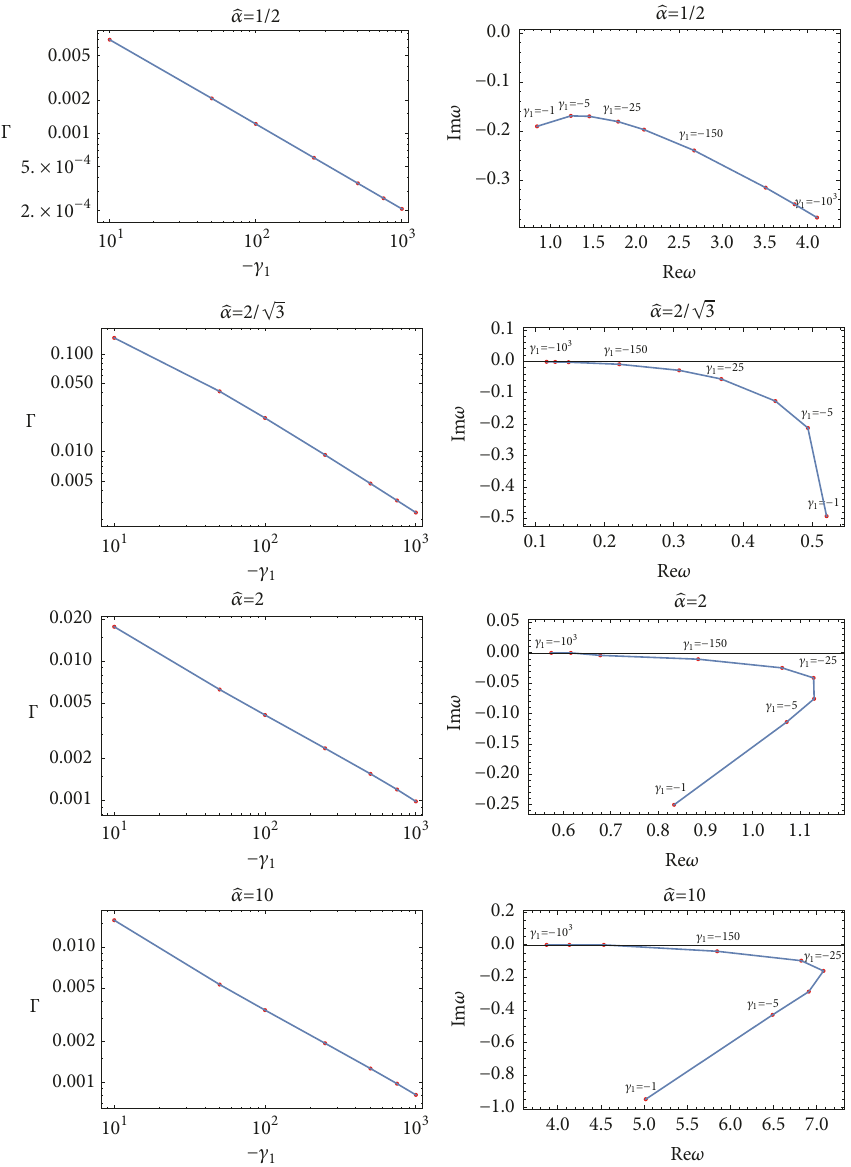
Figure 12: Left plot: location of the dominate QNM for different ̂𝛼 . Red dots are the numerical data and the blue line is the power-law fit of the form 𝑎/|𝛾 1 | 𝑏 . Right plot: location of the next QNM closet to the real axis, a zero, for different ̂𝛼